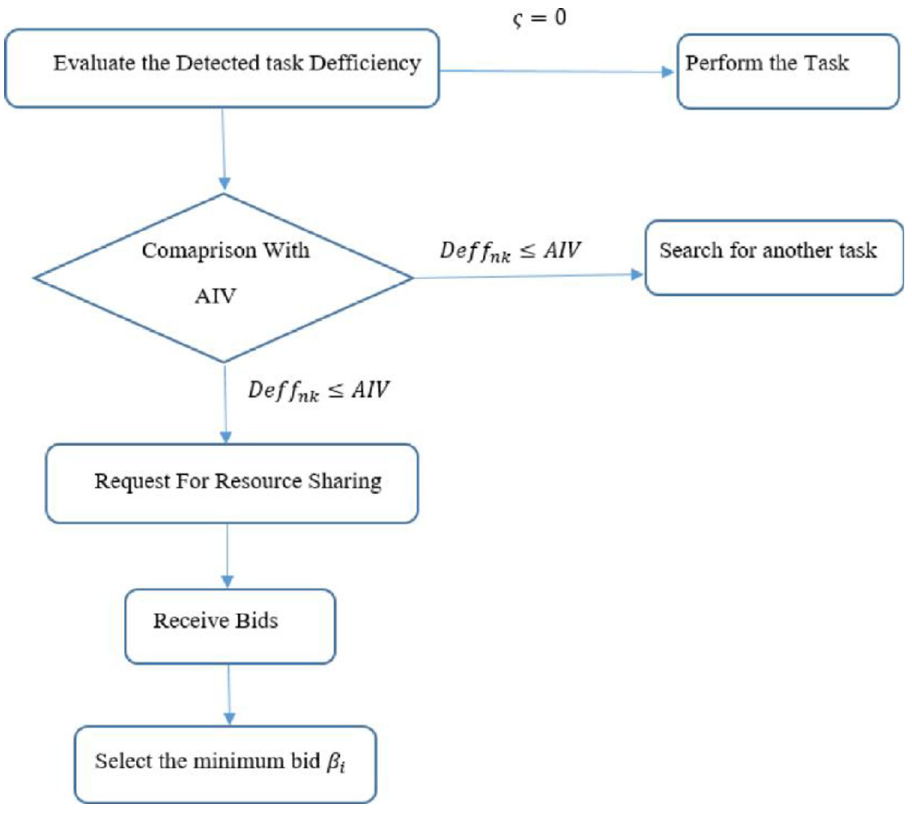
Fig 6. Auctioneer’s